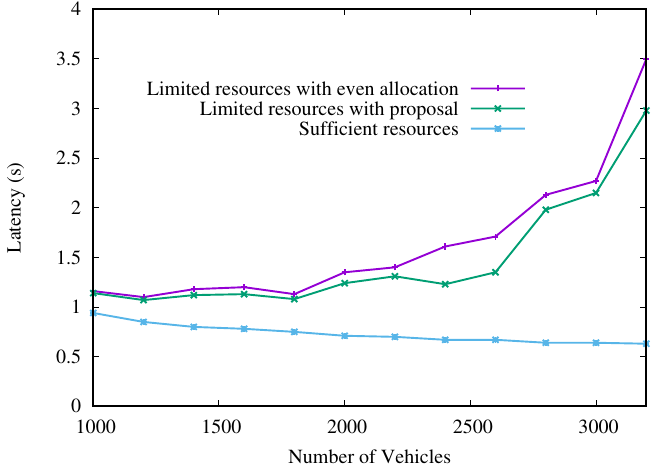
Figure 10. Latency performance of the system with coexisting tasks.